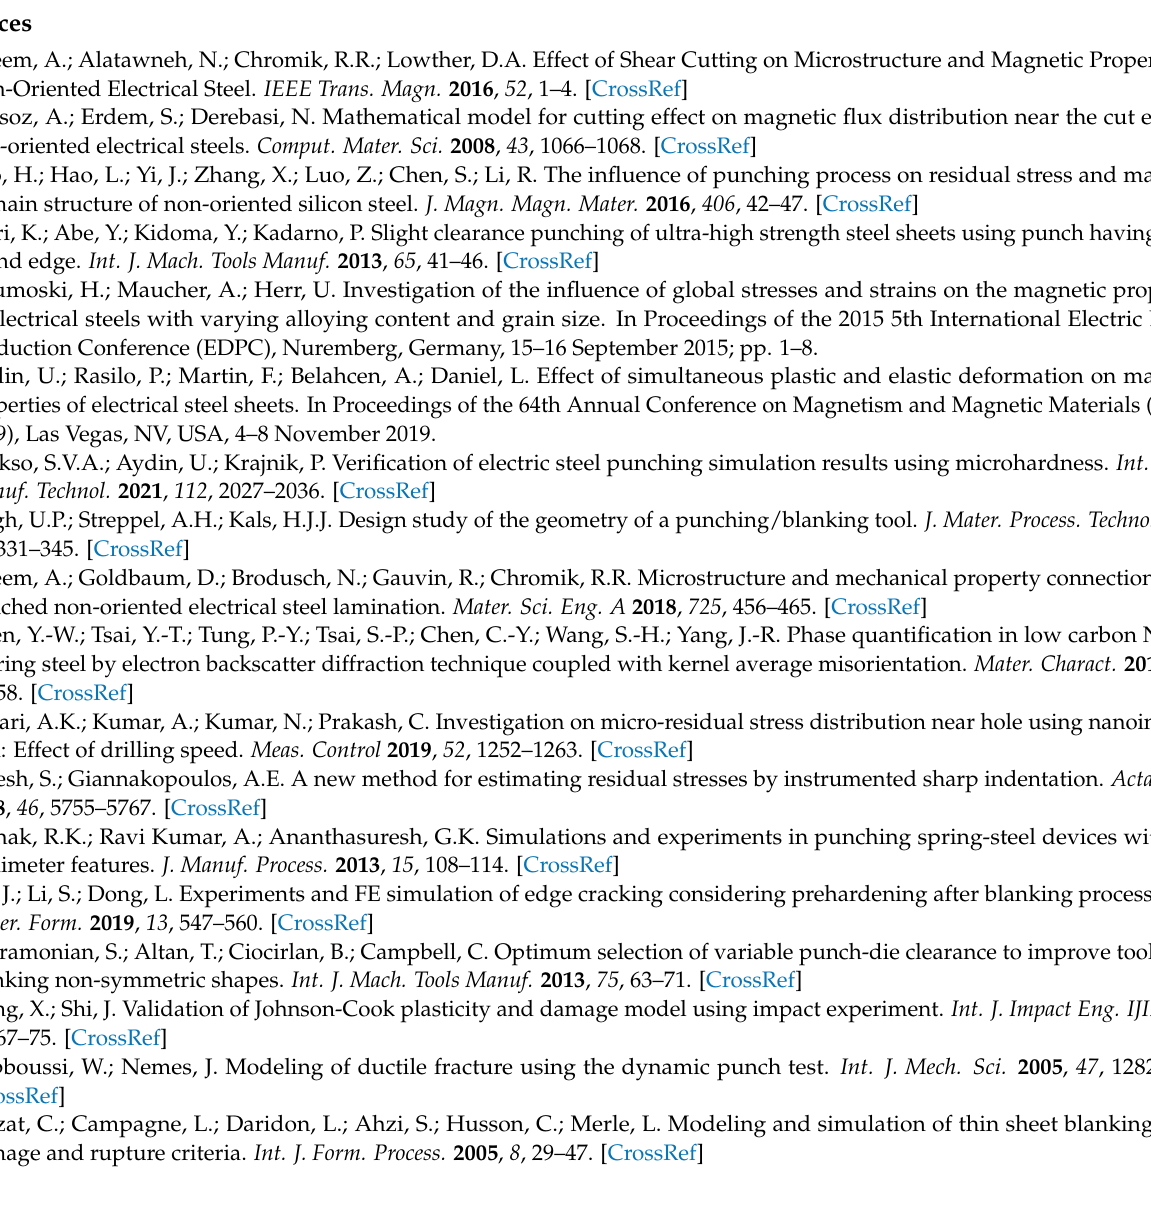
(d) The formation of tensile residual stress on the surface of a punched sample depends on the formation of a bent area with the blunt tools. Punch tools with high wear will form a large bending area at the cutting edge with a large and deep tensile stress region on the surface, which will be retained after